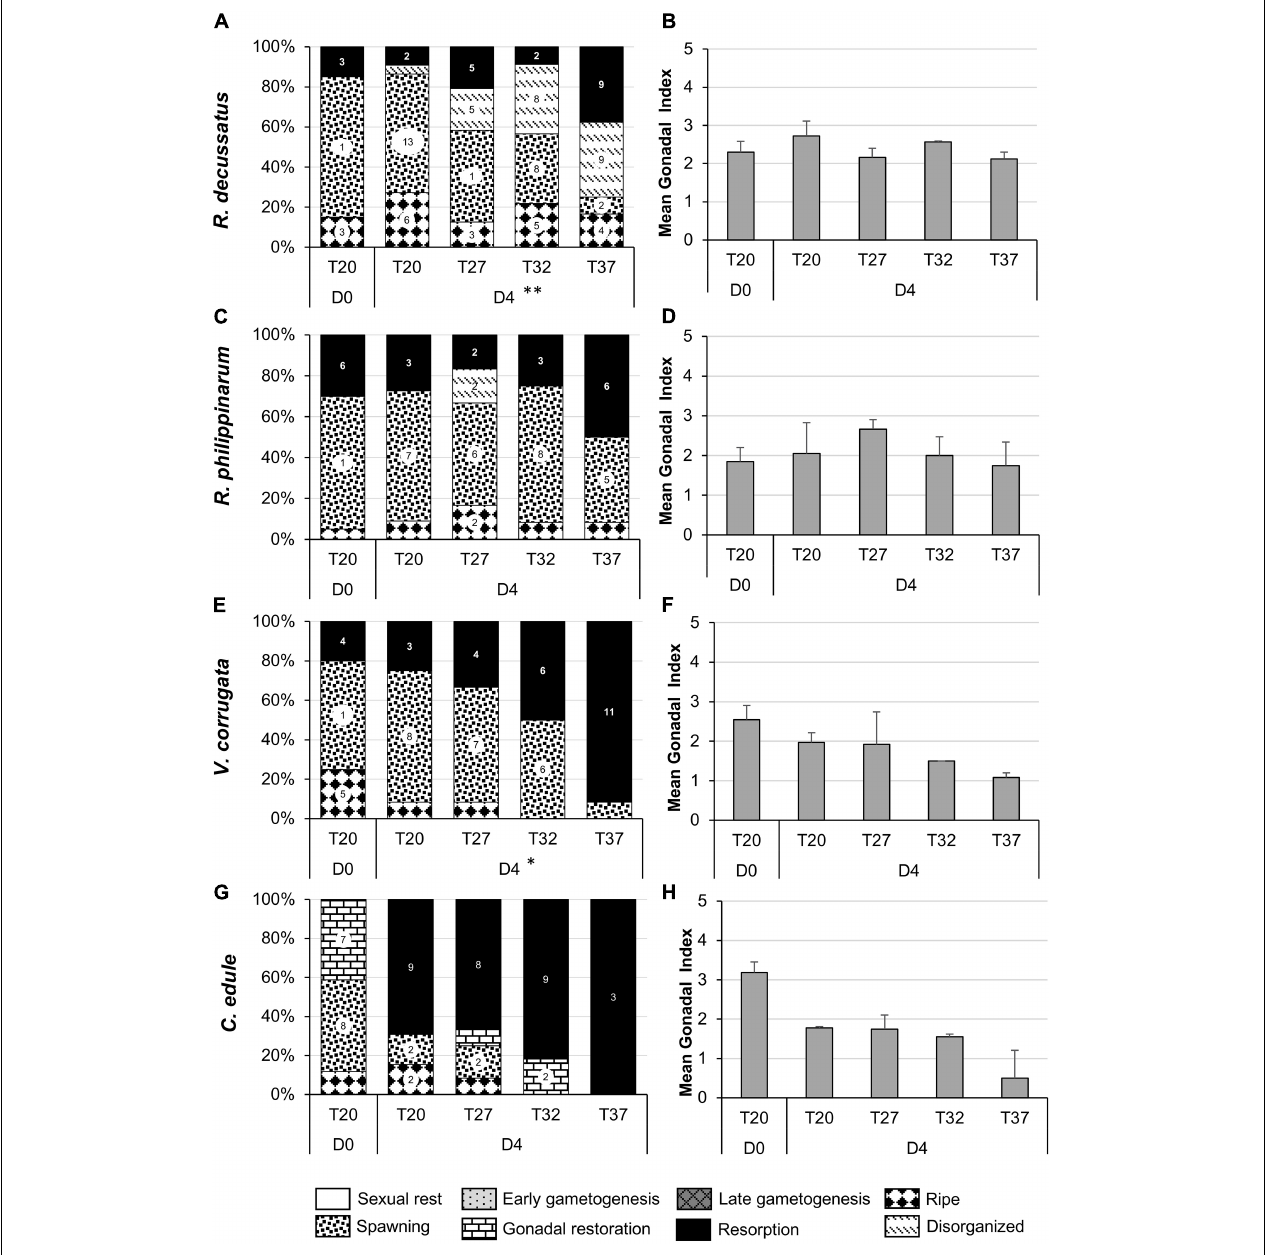
FIGURE 8 | Gonadal stages (percentage) (A,C,E,G) and gonadal index (mean + SD) (B,D,F,H) in the July heat wave experiment in each temperature treatment at the beginning of the experiment (D0) and after four days of stress (D4). Surface sediment temperature treatments: T27 corresponds to a temperature ramp from 20 to 27 ◦ C, T32 from 20 to 32 ◦ C, T37 from 20 to 37 ◦ C, and T20 to control. (A,B) Ruditapes decussatus ; (C,D) Ruditapes philippinarum ; (E,F) Venerupis corrugata ; (G,H) Cerastoderma edule . Asterisks refer to the significance of the multinomial logistic regressions: ∗ p < 0.05; ∗∗ p < 0.01. Number in the bars indicate number of individual clams within categories. Categories without number but present in the graph means one